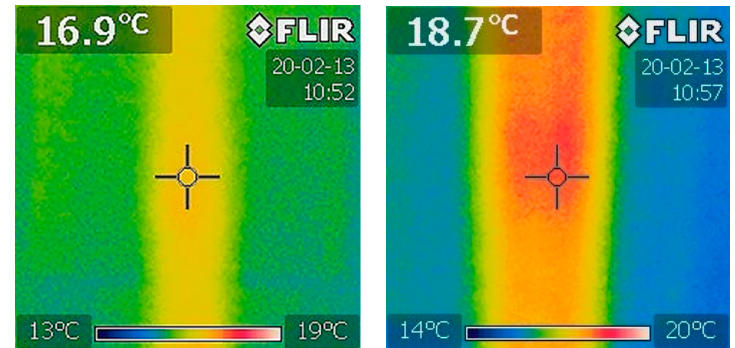
Figure 16. Temperature measurements of the carbon fiber under tensile test.